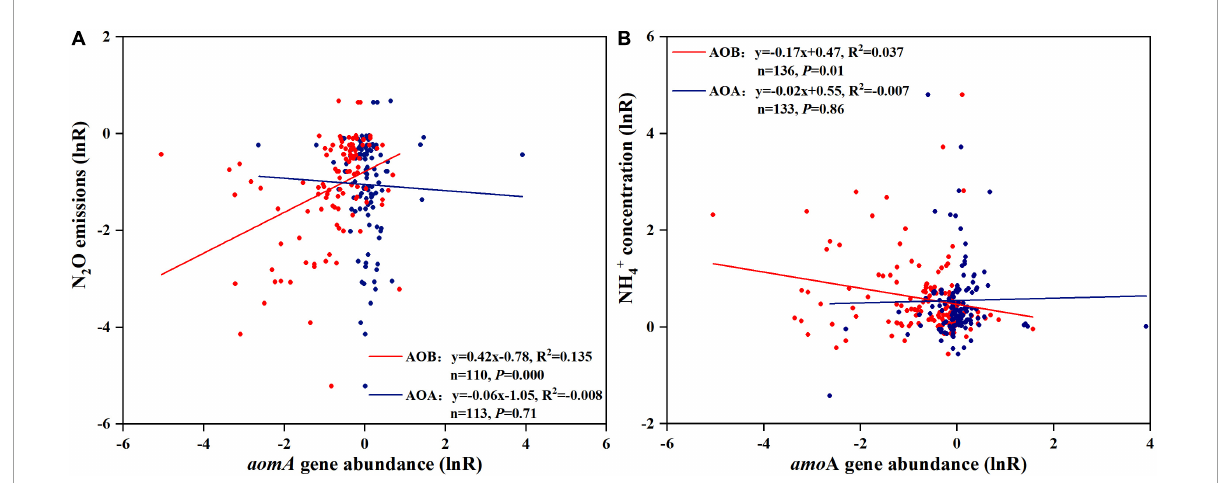
FIGURE4 Relationship between effect size (lnR) of N 2 O emissions (A) or NH + 4 concentration (B) and effect size (lnR) of AOA and AOB amo A gene abundance. Line is the best-fit regression, where AOB-NIs effectiveness is the red line and AOA-NIs effectiveness is the blue line. Each symbol represents one observation; red point, AOB, blue point,